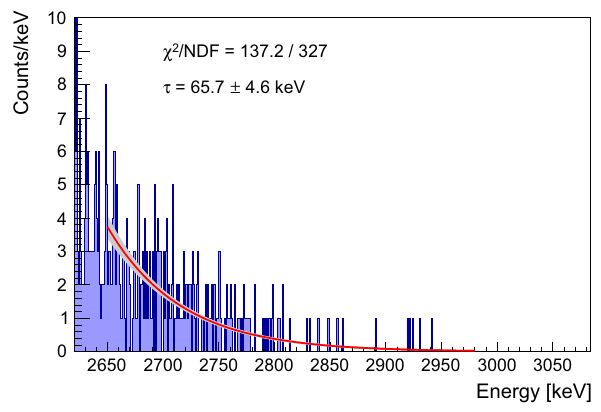
Fig. 14 The exponential plus flat background fit used to determine a prior on the slope of any exponential background. The fit favors an exponential term with no flat background, however owing to the low statistics it is not sufficient to rule out the presence of a flat background